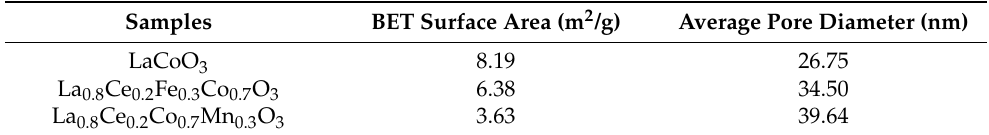
Table 2. The Textural parameters of catalyst samples.